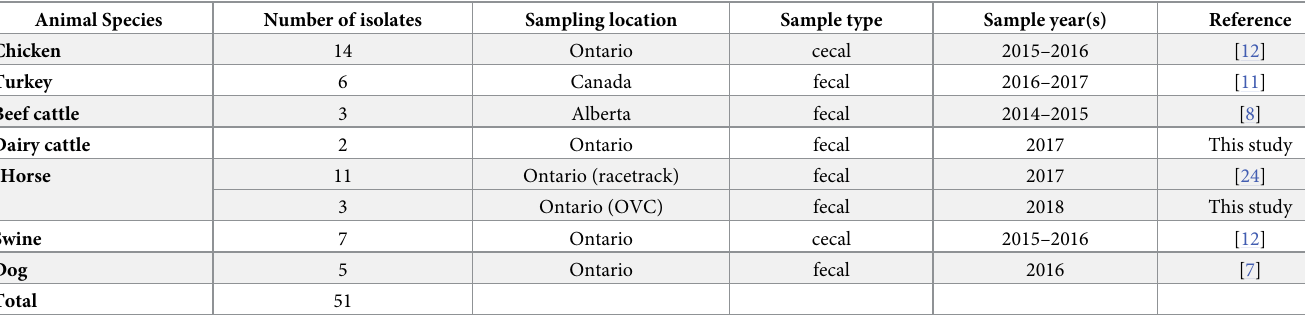
Table 1. Sampling characteristics of E . coli isolates selected for analyses. Animal